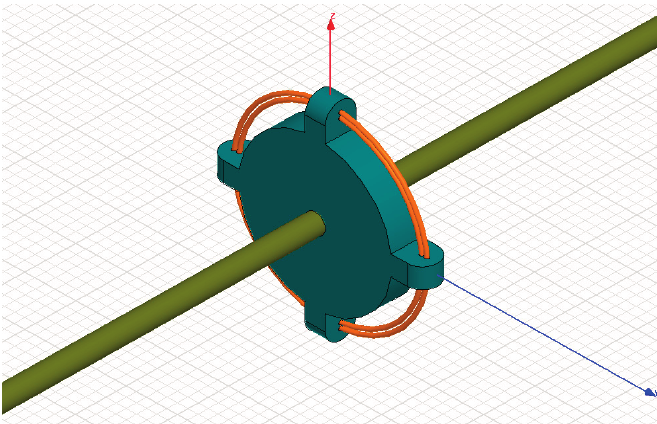
Figure 7. Simulation model of D-dot